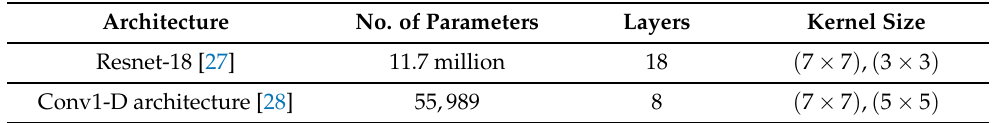
Table 2. Model architecture used in the experimental